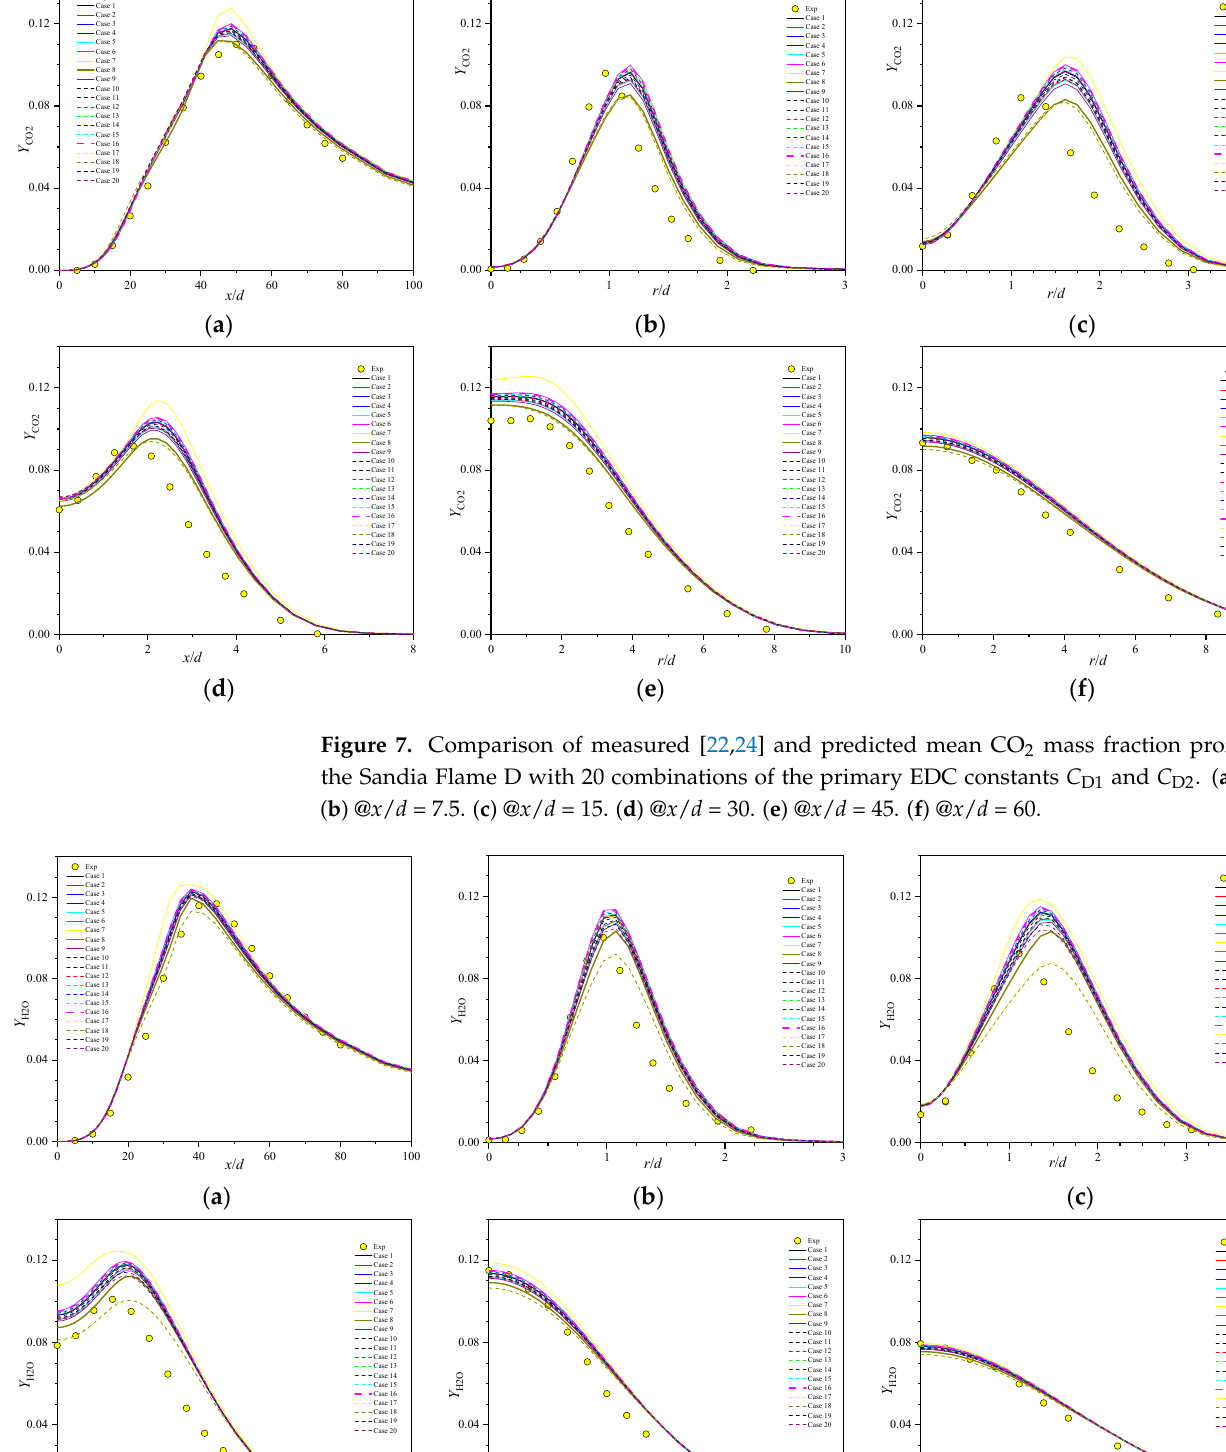
the zones where the reactions of the mixtures are almost done, such as at x / d = 60, the dicted results of other cases, cases 8, 17, and 18 are found to agree well with the experi- ments for both the axial and the radial mean H 2 O mass fractions.